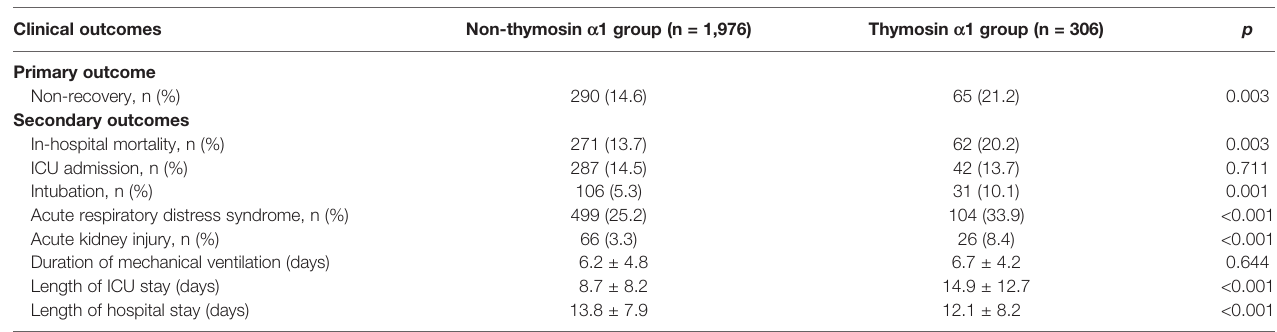
ICU, intensive care